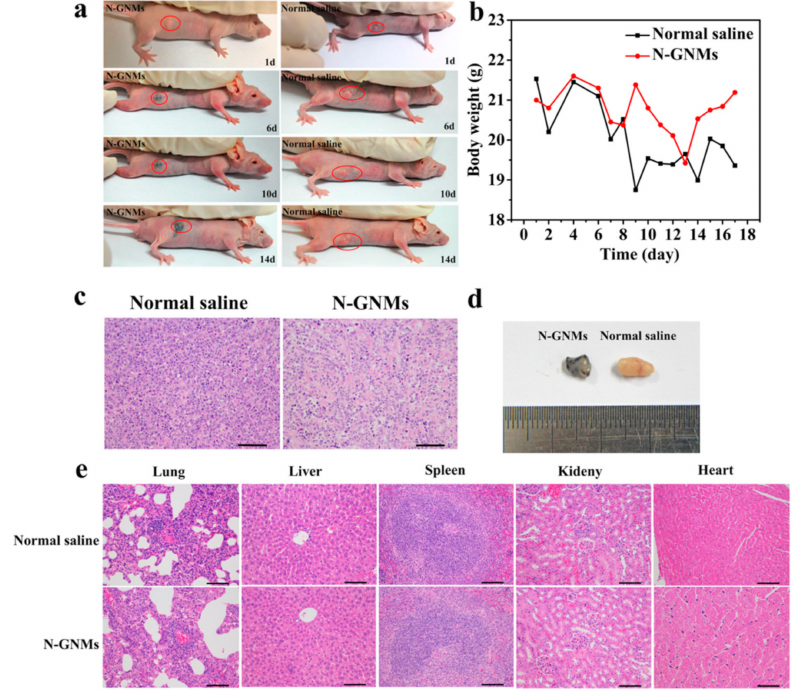
Figure 6. In vivo cancer therapy efficacy. ( a ) Representative photos of mice after different treatments for 1, 6, 10 and 14 days; ( b ) Representative tumor tissues collected from different groups at 14 days; ( c ) Hematoxylin and eosin (H and E) stained slices of tumor tissues from different groups collected at 14 days. Scale bar: 100 µ m; ( d ) Body weight changes in HeLa tumor-bearing mice after various treatments for 14 days; ( e ) Histological H and E staining of major organs in nude mice after 14 days. Scale bar: 100 µ